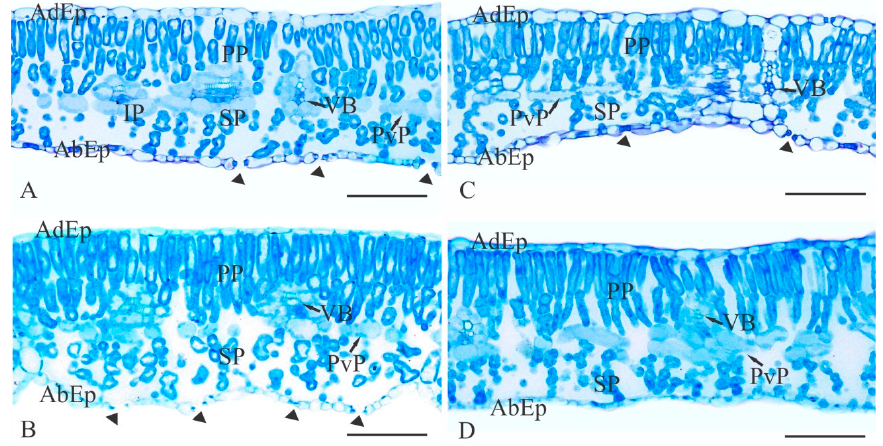
Figure 2. Cross-sectional photomicrographs of soybean leaf blades showing the mesophyll thickness after the treatments with temperature ( ◦ C) and SNP application (100 µ M): A —25 ◦ C; B —25 ◦ C + SNP; C —40 ◦ C; and D —40 ◦ C + SNP. AdEp: adaxial epidermis; AbEp: abaxial epidermis; PP: palisade parenchyma; SP: spongy parenchyma; PvP: paravenous parenchyma; VB: vascular bundle. Arrowheads indicate stomata. Scale bars = 100 µ m. For color version, the reader is referred to the web version of this